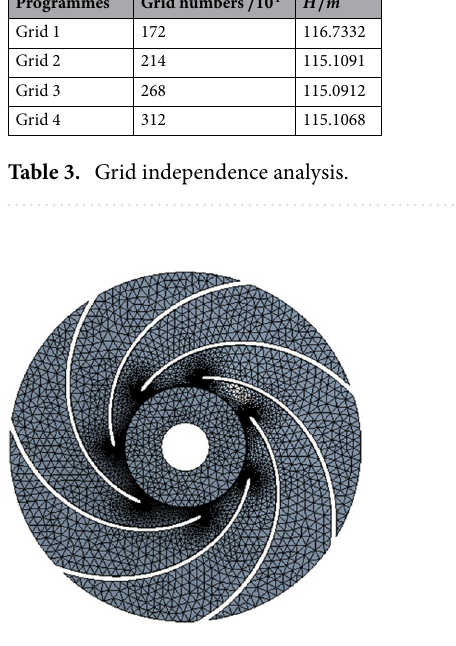
Figure 2. Impeller grids.